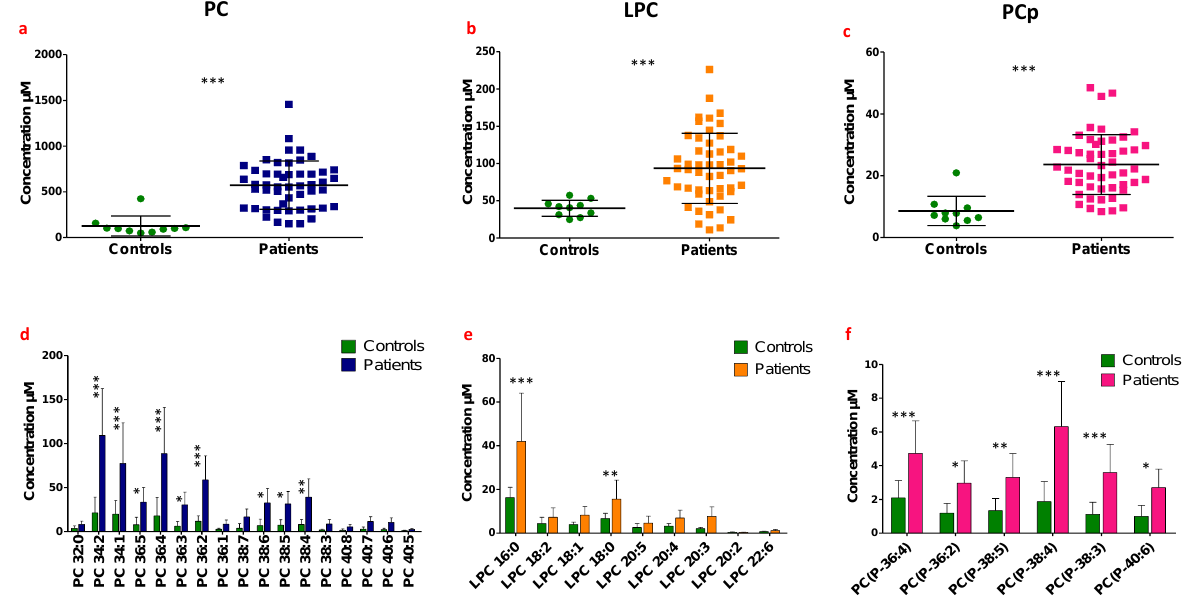
Figure 2. Comparison between lipid levels in HSF samples of the cohort of patients suffering from joint pain associated with different rheumatic diseases (Patients) and post-mortem controls (Controls). Lipids were extracted from HSF samples and the levels of PC, LPC and PCp species were measured based on ESI-MS analysis after the addition of lipid internal standards. The comparison between the total amount of each lipid class between the patients and the controls was based on an unpaired t-test, while the two-way ANOVA test was performed to compare multiple lipid species within each lipid class. ( a ) and ( d ) Histogram representing the comparison of the total PC concen- tration and individual PC species concentrations (µM) in HSF between patients and controls. ( b ) and ( e ) Histogram representing the comparison of total LPC concentration and individual LPC spe- cies concentrations between patients and controls. ( c ) and ( f ) Histogram representing the compari- son of total PCp concentration and of individual PCp species concentrations between patients and controls. ns: not significant p > 0.05, *: 0.01 < p < 0.05, **: 0.001 < p < 0.01 and ***: p < 0.001.